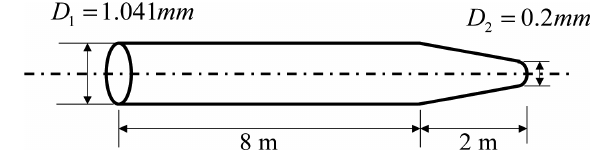
Fig. 10. Geometries of fl y line.